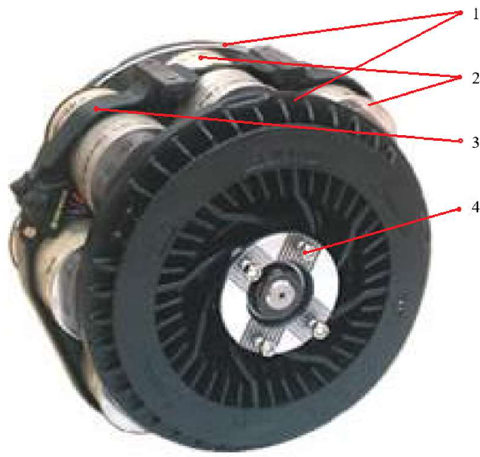
Figure 3. Electromagnetic brake: 1—metal disk (rotor), 2—electromagnetic coils, 3—housing, 4— attachment to the wheel hub.